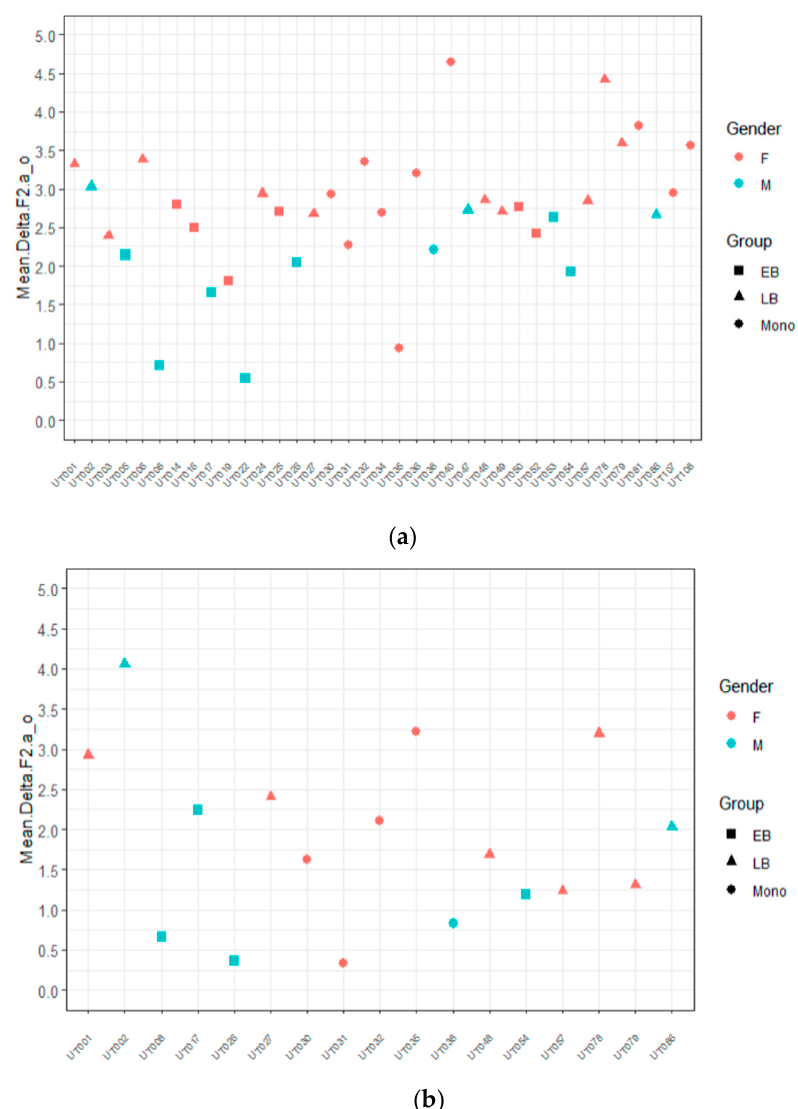
Figure 5. F2-F1 in Bark for the vowel / a / : ( a ) Values obtained for / a / minus values obtained for / o / in predictable contexts; ( b ) values obtained for / a / minus values obtained for / o / in non-predictable contexts.